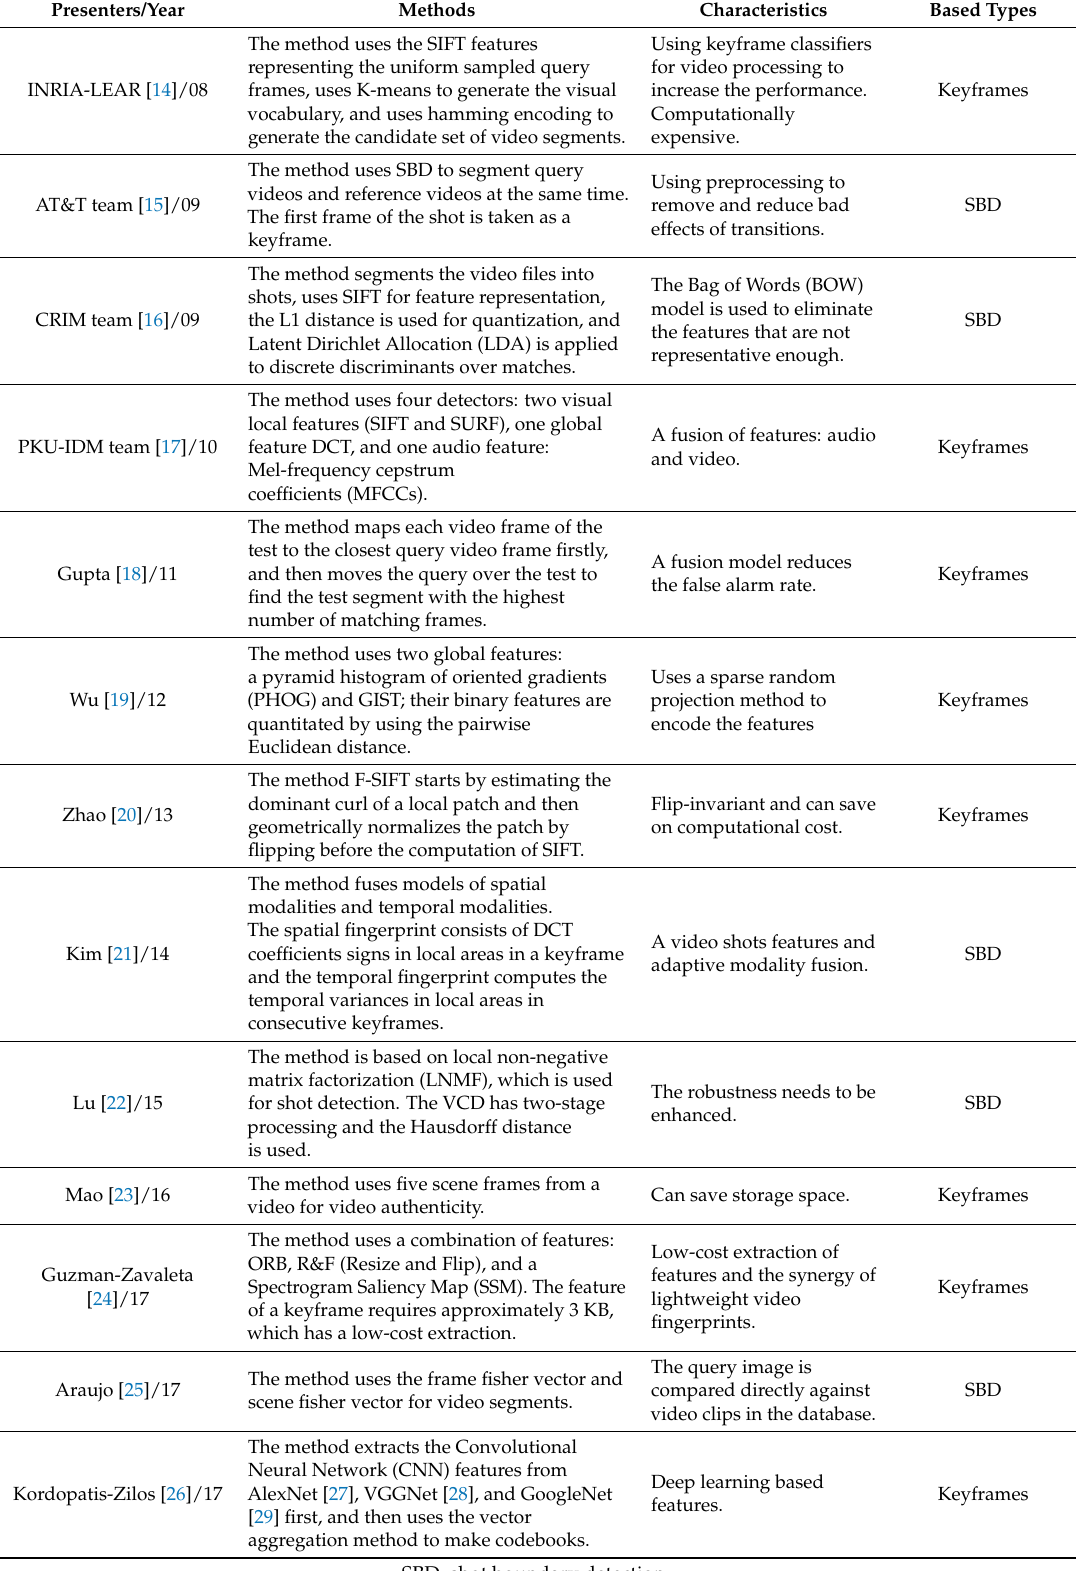
Table 2. Description of the video copy detection (VCD)